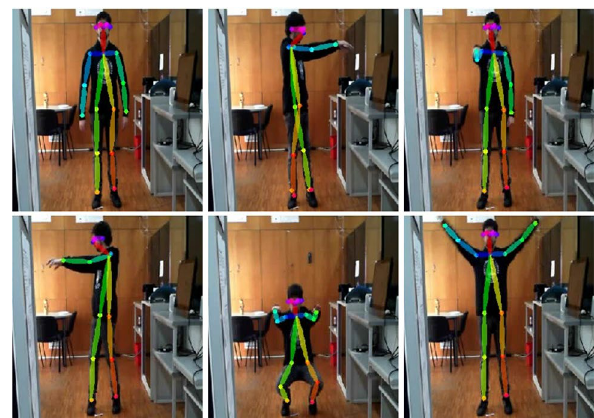
Fig. 3 A user executing exercises accompanied by the robotic buddy and guided by the virtual coach on the screen